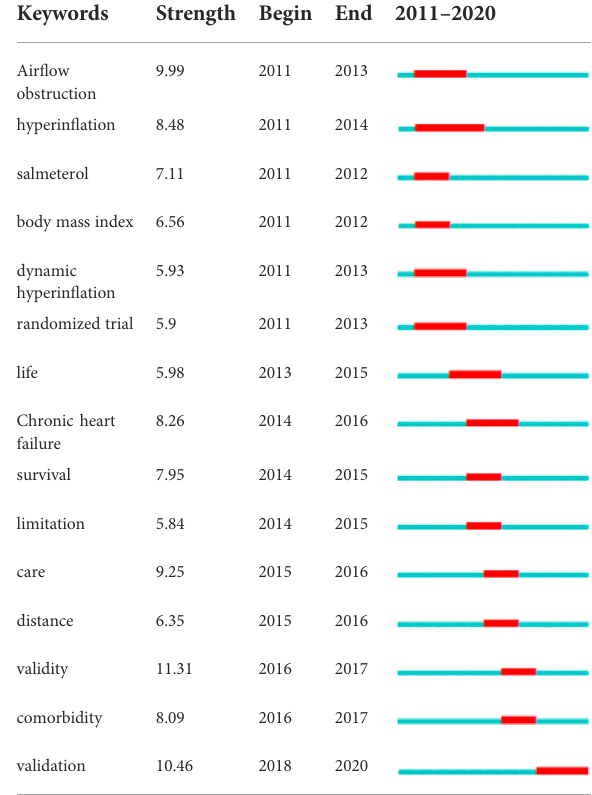
TABLE 8 Top 15 keywords with the strongest citation